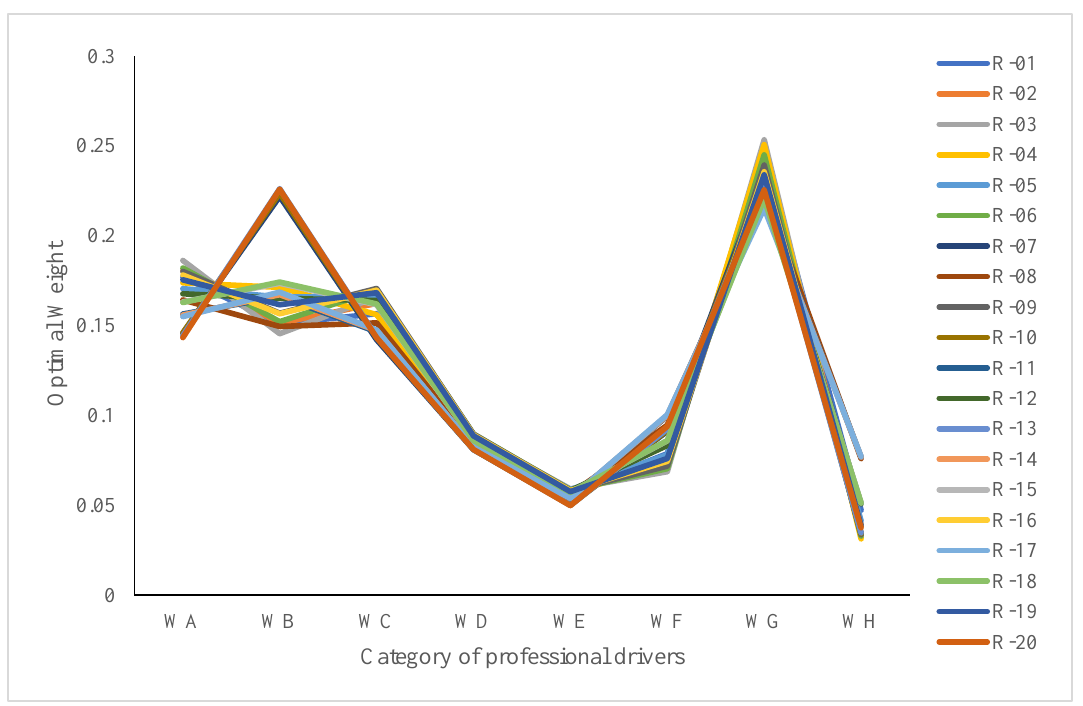
Figure 2. Variation in the weight of different categories of professional drivers during sensitivity analysis.